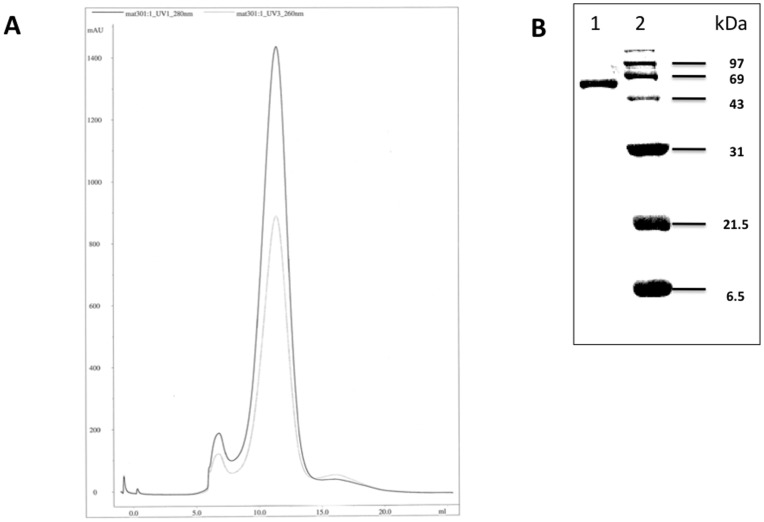
Characterization of heparin-activated ATIII.(A) Sepharcyl S100 ÄKTA FPLC of purified hep-ATIII. A 9–14 ml fraction was separated, termed as hep-ATIII and used for our experiments. Detection at 260 nm for protein detection and 280 nm for heparin detection is shown. (B) Hep-ATIII purity and molecular weight were also determined by SDS-PAGE and silver staining (Bio-Rad kit) of a 15% slab gel. For molecular weight determination a low-range protein molecular weight marker (Bio-Rad) was used. Lane 1∶2 µg hep-ATIII; lane 2: phosphorylase B (97 kDa), serum albumin (69 kDa), carbonic anhydrase (31 kDa), trypsin inhibitor (21.5 kDa), aprotinin (6.5 kDa).